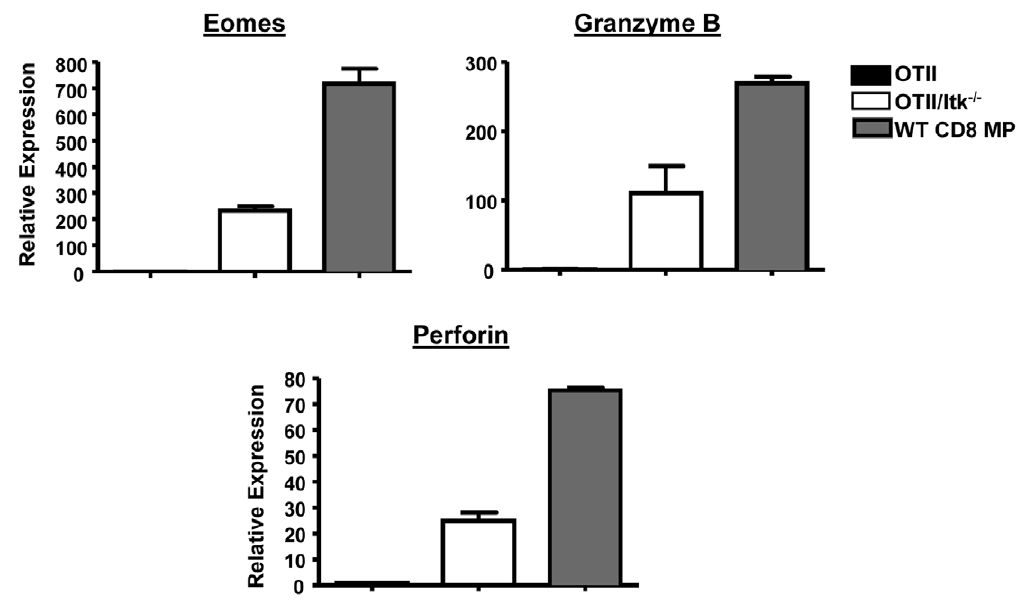
Figure 11. Itk mediated signals intersect with TCR affinity to regulate Runx3 regulated genes in naı¨ve or conventional CD4 + T cells. Quantitative real-time RT-PCR for Perforin, Granzyme B and Eomesodermin in sorted transgenic TCR hi CD4SP thymocytes from OT-II and OT-II/Itk 2 / 2 mice Data are corrected for GAPDH expression and expressed as fold over mRNA of the respective OT-II cells, which was set at 1 (n=3, *p , 0.05). Expression of these genes in sorted WT memory phenotype CD8 + T cells are shown as a reference.